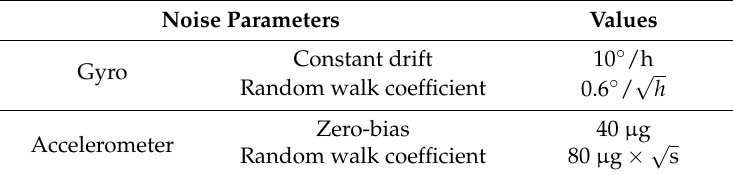
Figure 6. Navigation setup of the UAV. Table 3. Noise parameters of MTi-100 IMU.